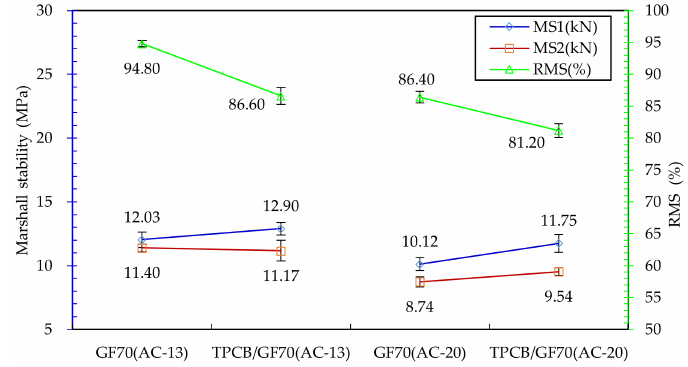
Figure 10. Results of immersion Marshall testing of GF70 and TPCB/GF70 asphalt mixtures.